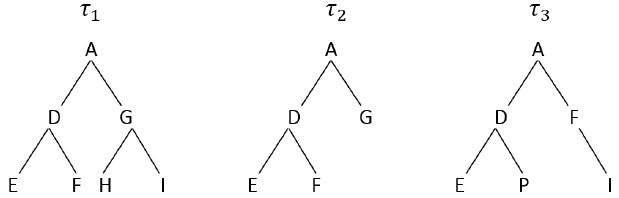
Figure 4. Example showing three distinct trees with different lengths and